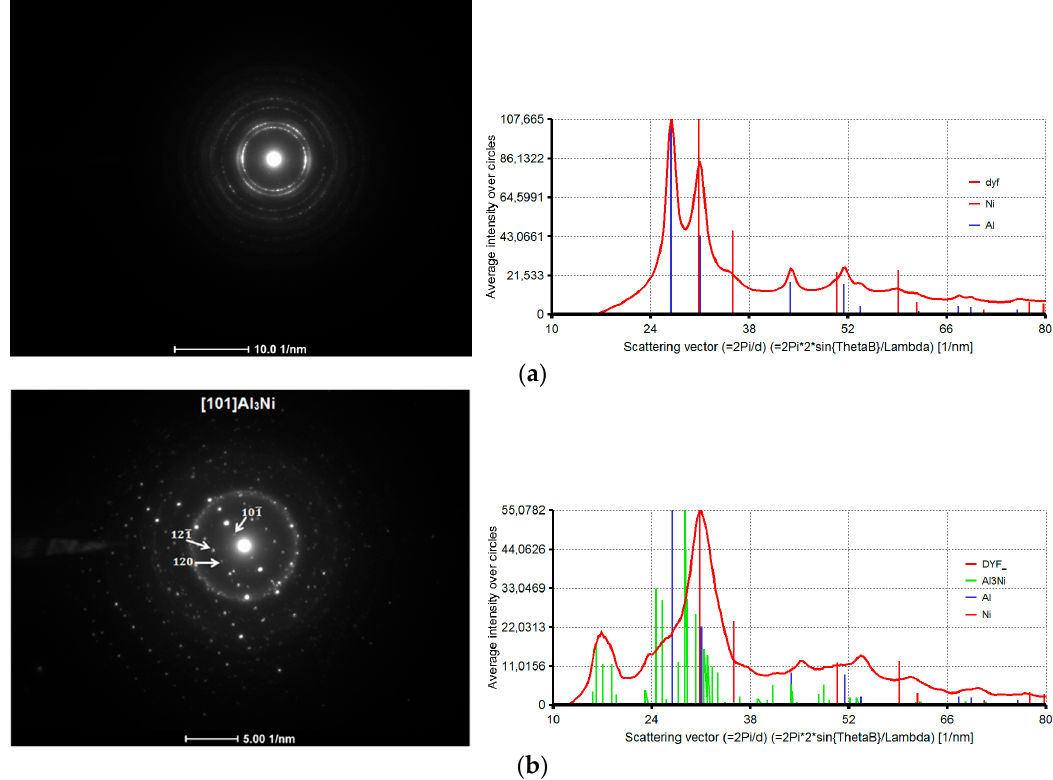
Figure 5. SAD patterns of Ni/Al multilayer thin films deposited onto W wires and respective diffraction spectra. ( a ) Middle and ( b ) bottom part of the wire.